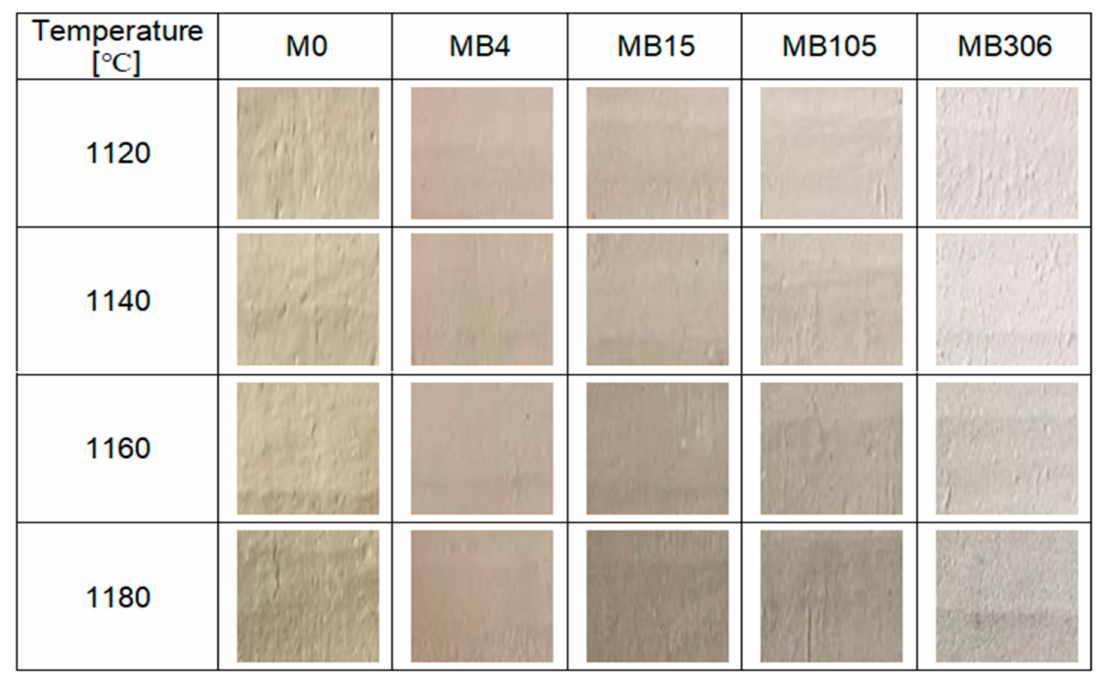
Figure 4. Color of the surface of obtained ceramic materials.